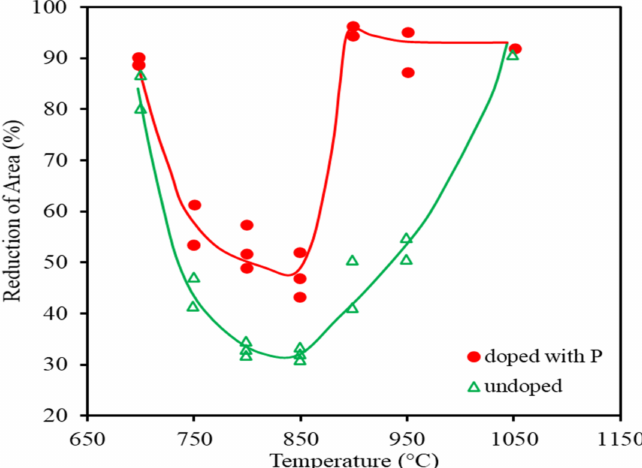
Figure 20. P addition of 0.054% P improving the hot ductility of a low alloy Cr-Mo steel